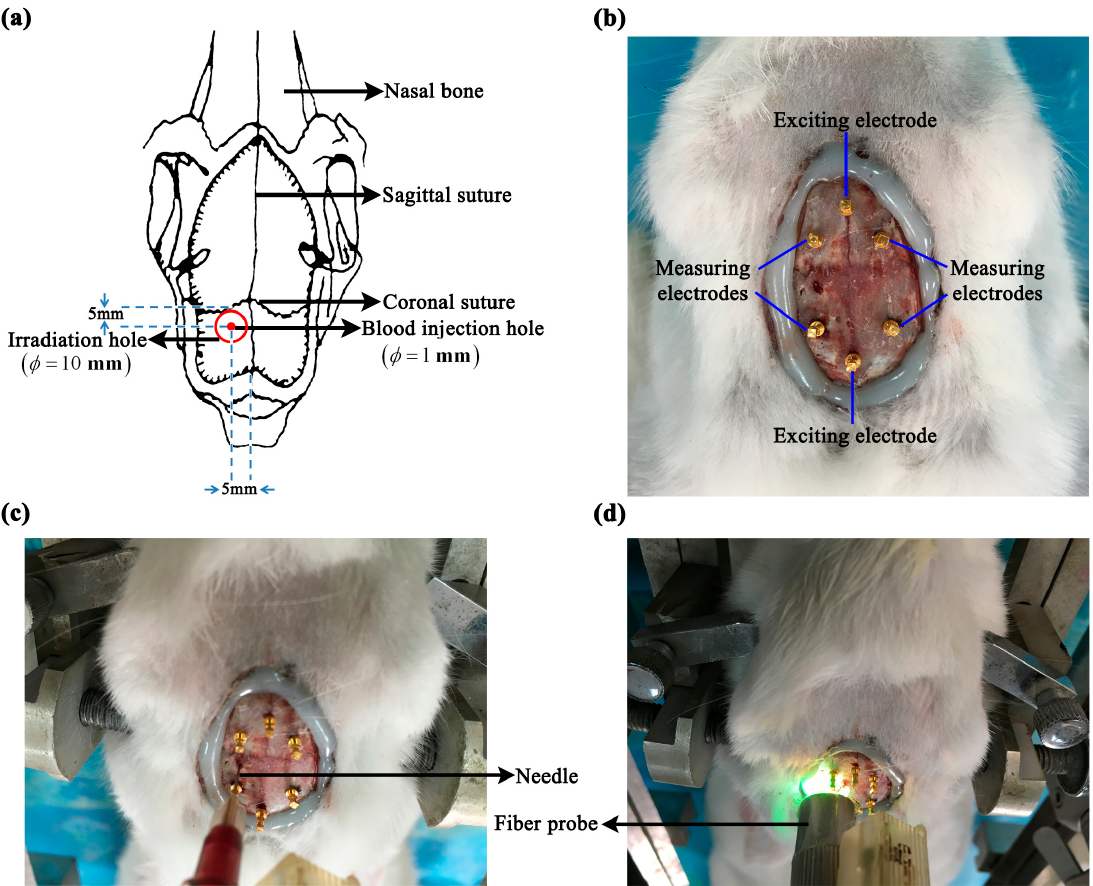
Figure 1. Localized intracerebral hemorrhage and ischemic models. ( a ) Schematic diagram. ( b ) Electrode distribution for in vivo measurement of whole-brain impedance spectra. ( c , d ) Intracerebral hemorrhage model (autologous blood injection method) and ischemic model (photochemical induction method).